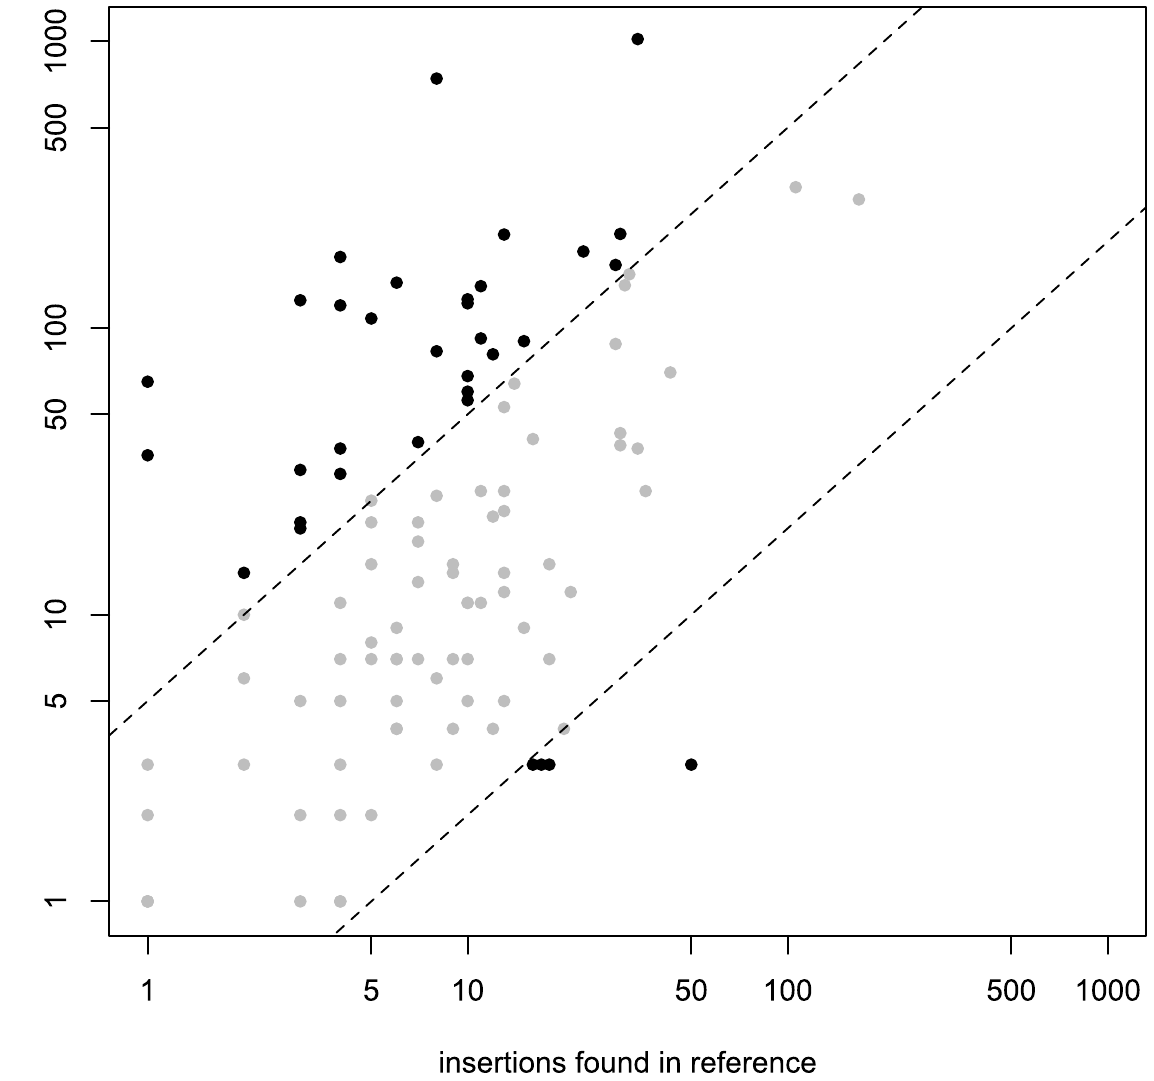
Figure 3. Number of novel identified TE insertions compared to known TE insertions for every TE family. Dashed lines mark the regions of five-fold difference between the number of novel and known TE insertions.